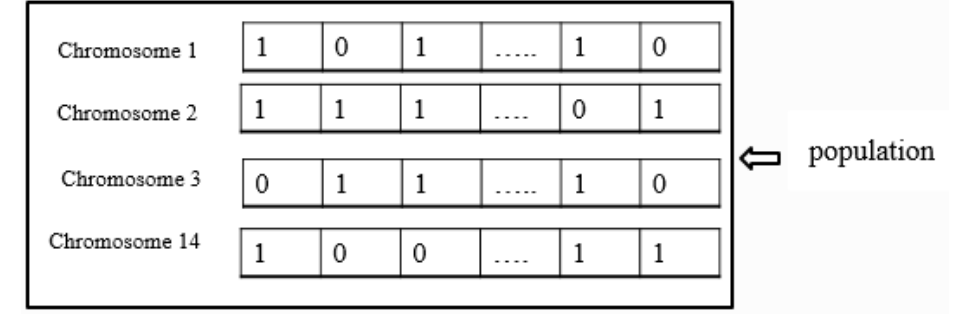
Fig. 4. The initial population of GA.